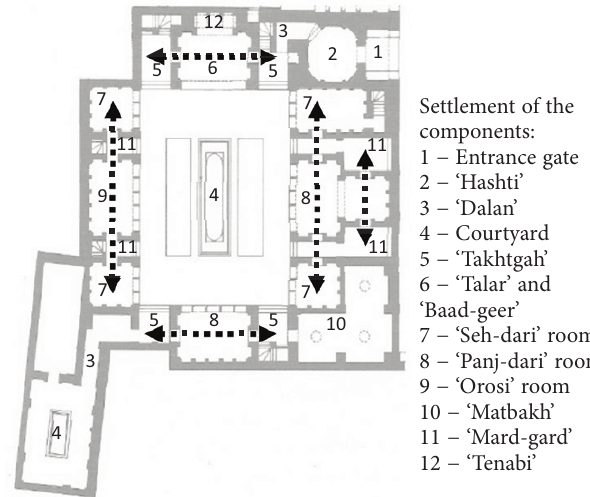
Figure 2. The soft Connection in the form of the portable thresholds in an inward-looking traditional Persian house, Sample 32 (Plan source: Ghezelbash & Abouzia, 1985,